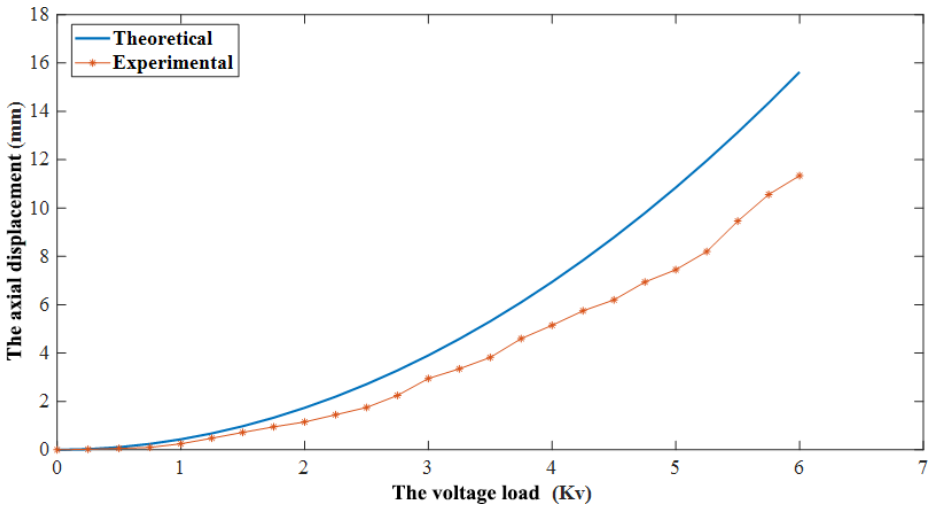
Figure 10. The result of the isotonic test.